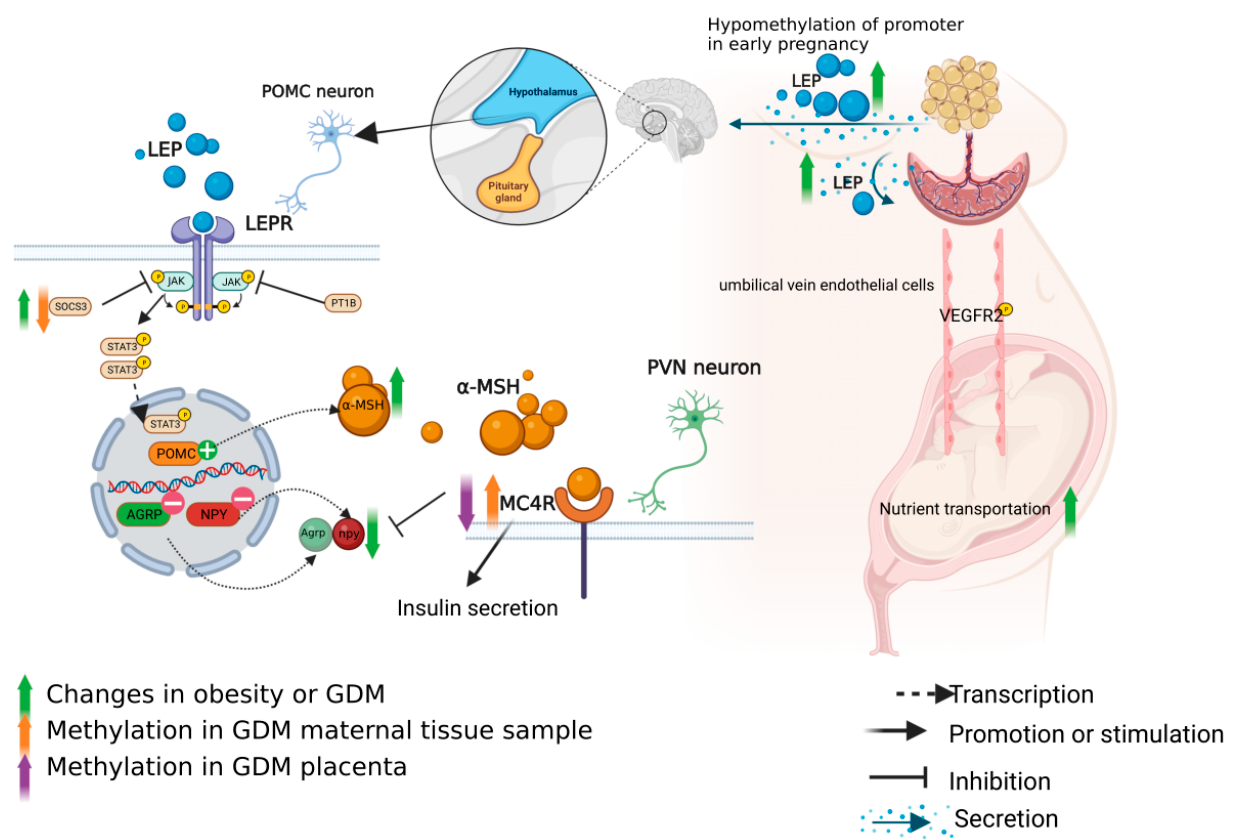
Figure 3. Leptin signal transduction and DNA methylation changes of related molecules in GDM and obesity. The images in this figure were taken from https://biorender.com/(accessed on 22 No- vember 2022) . November